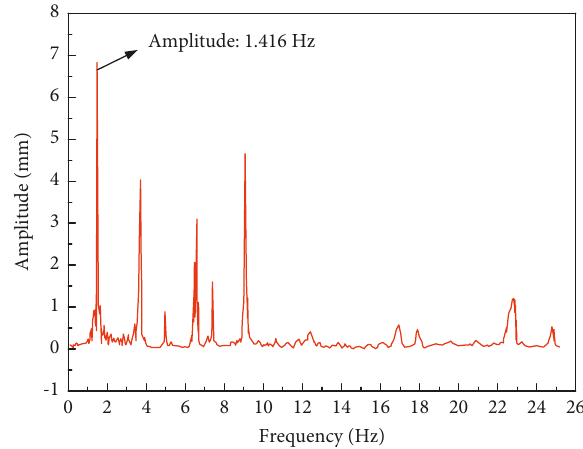
Figure 11: Vibration displacement spectrum of observation point